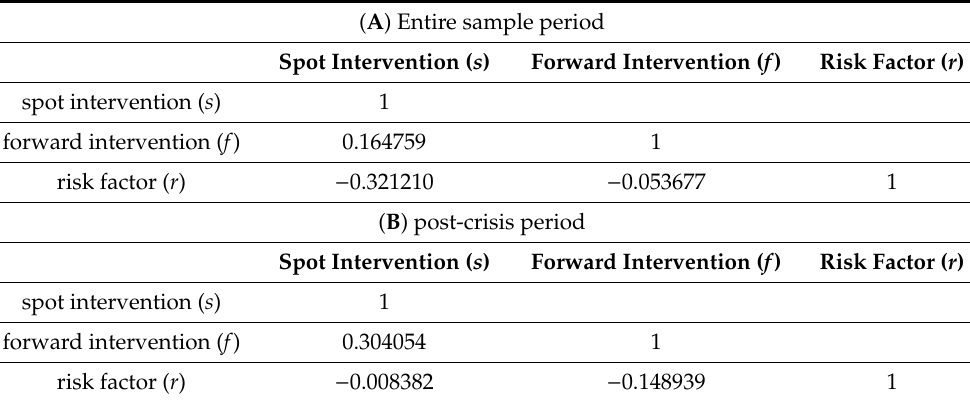
Table A1. Correlation matrix of variables used in the regression